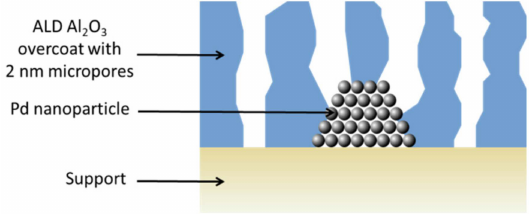
Figure 13. Schematic representation of a supported Pd nanocatalyst with a thermally activated ALD Al 2 O 3 microporous overcoat. Adapted from [102], American Association for the Advancement of Science,